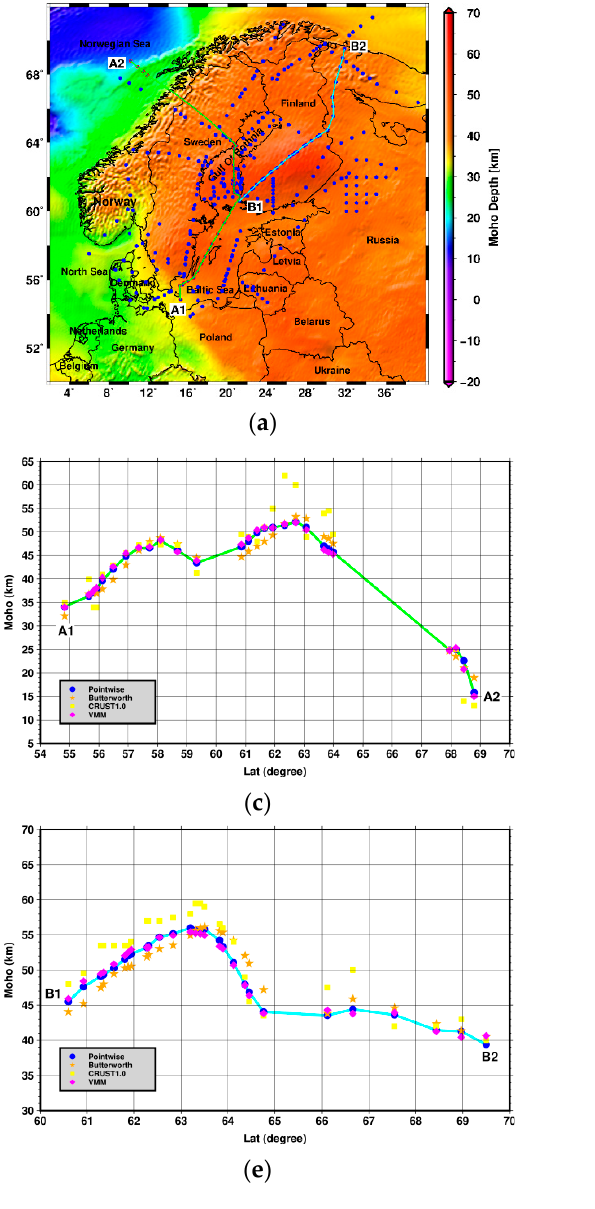
Figure 7. The HRCM Moho depth solutions obtained by applying: ( a ) the Butterworth filter and ( b ) the spectral combination. Seismic profiles A1–A2 and B1–B2 are indicated by green and blue lines, respectively. Locations of seismic stations are indicated by blue dots. The Moho depth differences between the HRCM Butterworth filter solution and the point-wise seismic Fennoscandia Moho depth estimates [30] along ( c ) the A1–A2 and ( e ) B1–B2 profiles. The Moho depth differences between the HRCM spectral combination solution and the point-wise seismic Fennoscandia Moho depth estimates [30] along ( d ) the A1–A2 and ( f ) B1–B2 profiles. The HRCM Moho depth results are given on a 5’ × 5’ grid. Unit: km. Table 4. Statistics of the HRCM Moho depth differences with respect to the point-wise seismic Fen- noscandia Moho depth estimates [30] along the A1-A2 and B1-B2 profiles. Unit: km.